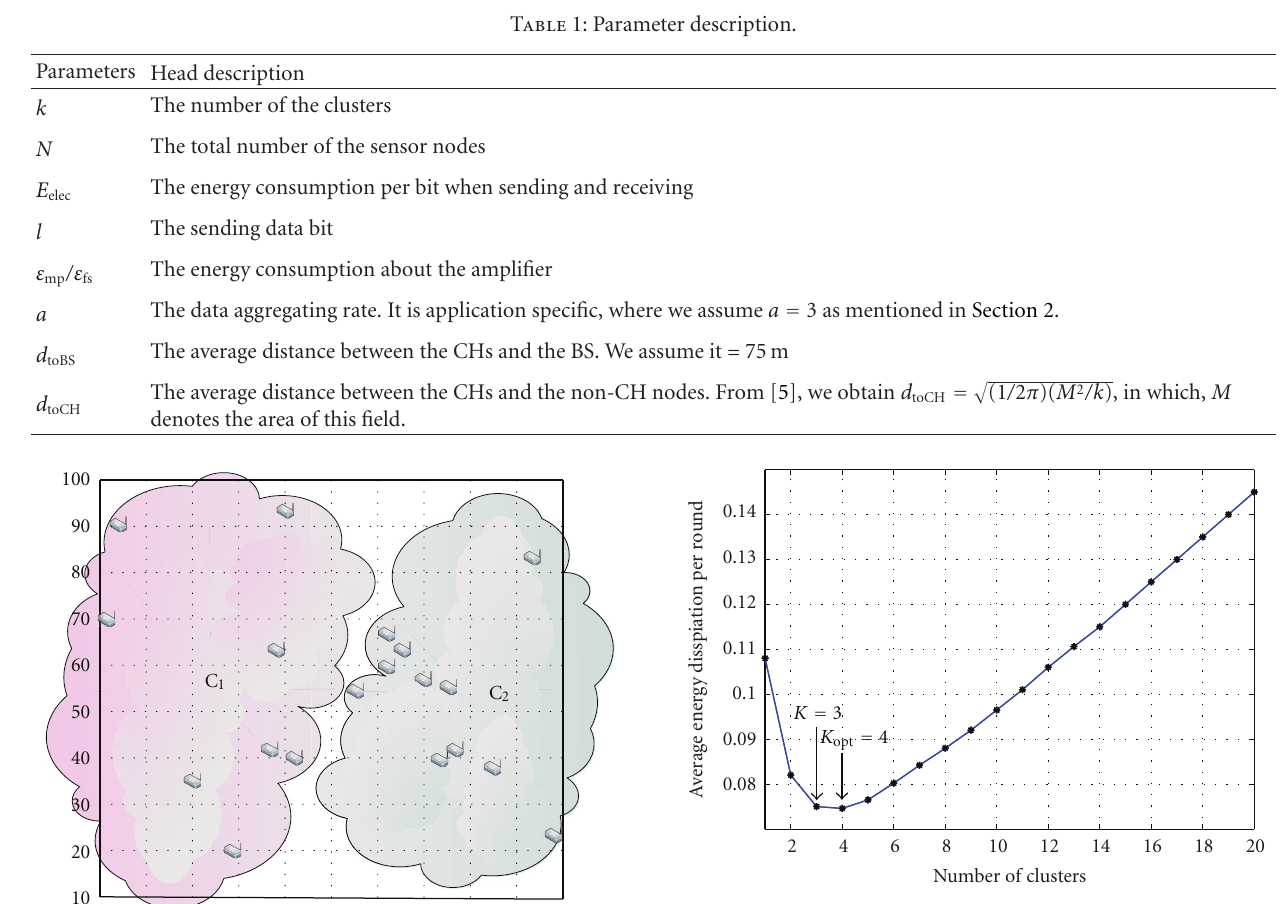
Figure 3: Average energy dissipation per round with varying the number of